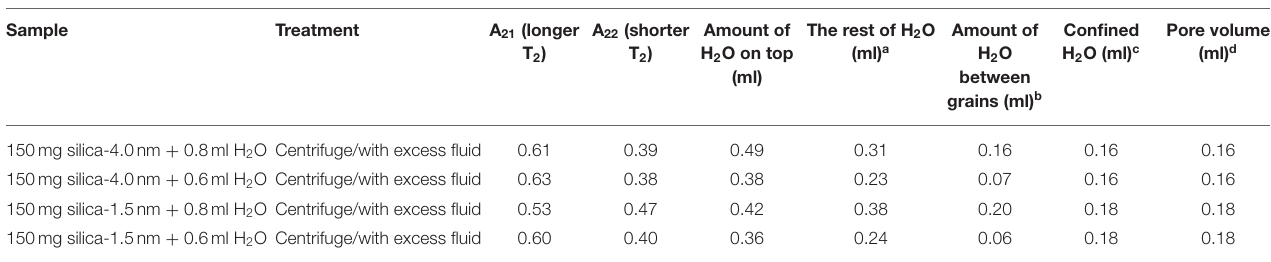
TABLE 3B | Quantification of confined vs. excess